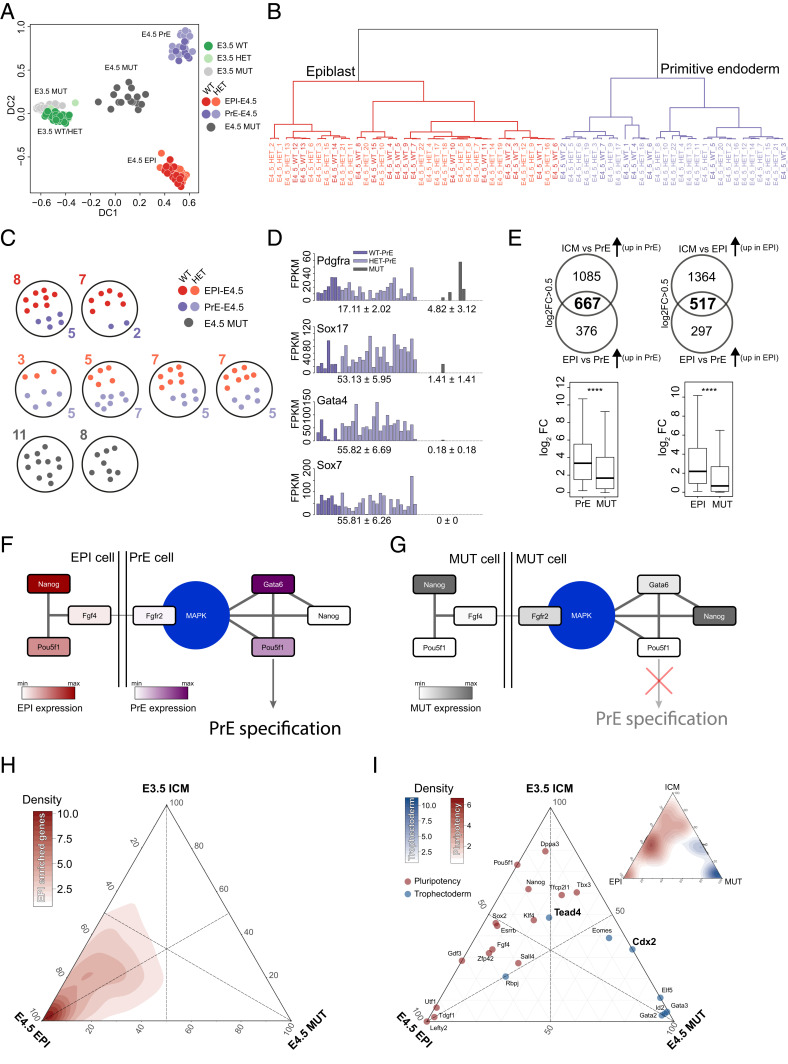
(A) Diffusion plot of early and late blastocyst cells; color represents the different genotypes and lineages. (B) Dendrogram (agglomeration method: ward.D2) for late blastocyst ICM WT/HET cells and (C) schematic representation of the number of late ICM single cells per embryo and their genotype. (D) Single-cell FPKM expression of PrE markers and mean ± SD (P adjusted Pdgfra: 0.11, Sox17: 2.75 × 10−10, Gata4: 1.62 × 10−10, and Sox7: 1.62 × 10−10) in PrE and MUT cells. (E, Top) Venn diagram showing the number of significant (P adjusted < 0.05) and enriched PrE and EPI genes. (E, Bottom) Box plot of log2FPKM in late blastocyst PrE and MUT cells of 667 genes and late blastocyst EPI and MUT cells of 517 genes. (F) Network of genes associated with PrE specification in WT cells and (G) MUT cells. (H) Ternary plot of early WT/HET early blastocyst cells, WT/HET EPI, and MUT cells. Axes show the relative fraction of expression of 814 EPI-enriched genes or (I) pluripotent and TE-associated genes.